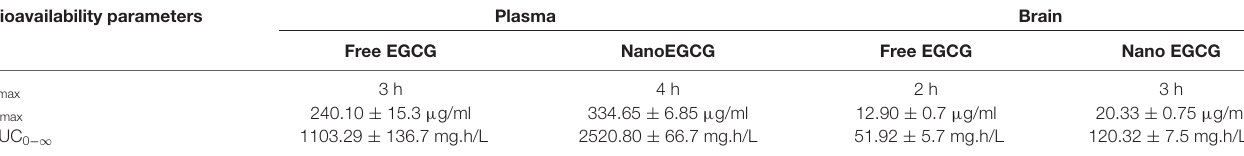
FIGURE 7 | Effect of AlCl 3 induction, free EGCG and nanoEGCG treatment on protein level profiles of A β 1–42 , AChE, APP, GSK3 β and PDK1 in the (A) hippocampus and (B) cortex regions of the rat brain. Abbreviations: C, control; AL, AlCl 3 induced Alzheimeric rats; EF, free EGCG treated AlCl 3 induced Alzheimeric rats; EN, nanoEGCG treated AlCl 3 induced Alzheimeric rats. Significance difference between groups indicated by: ∗ between C and AL, @ between AL and EF and # between AL and EN. TABLE 3 | Bioavailability parameters of unconjugated epigallocatechingallate (EGCG) after oral administration of nanoEGCG. Bioavailability parameters